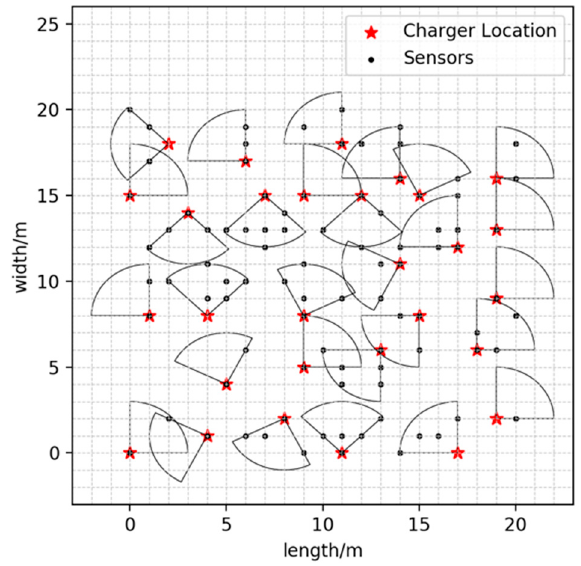
Figure 8. Illustration of the GMCU algorithm’s example result: DCV’s candidate charging locations and charging directions.